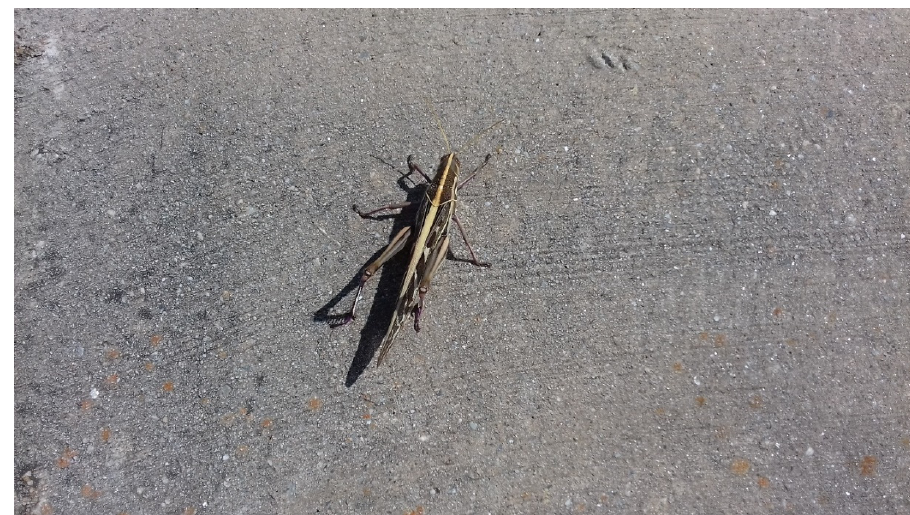
Figure 2. Grasshopper ( Eyprepocnemis plorans ).